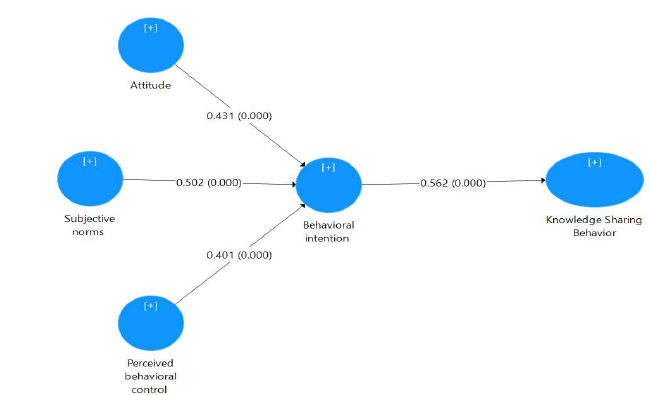
Fig. 2 . Bootstrapping results (Smart PLS